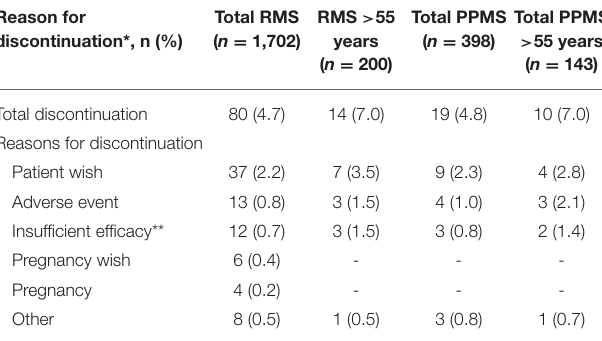
TABLE 3 | Reasons for discontinuation of ocrelizumab as reported by the investigator. Reason for discontinuation*, n